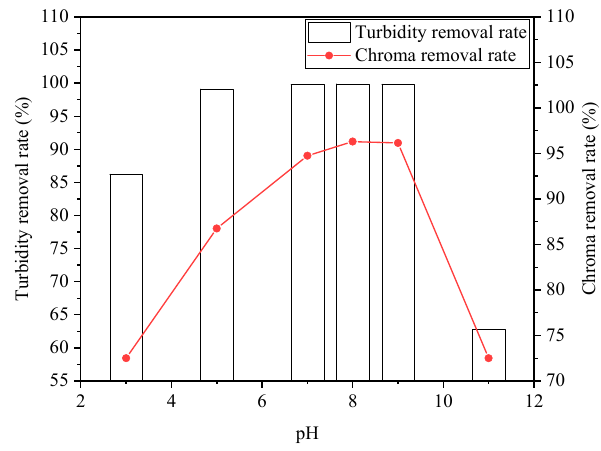
Figure 9. Effect of pH on removal rates of turbidity and chroma.